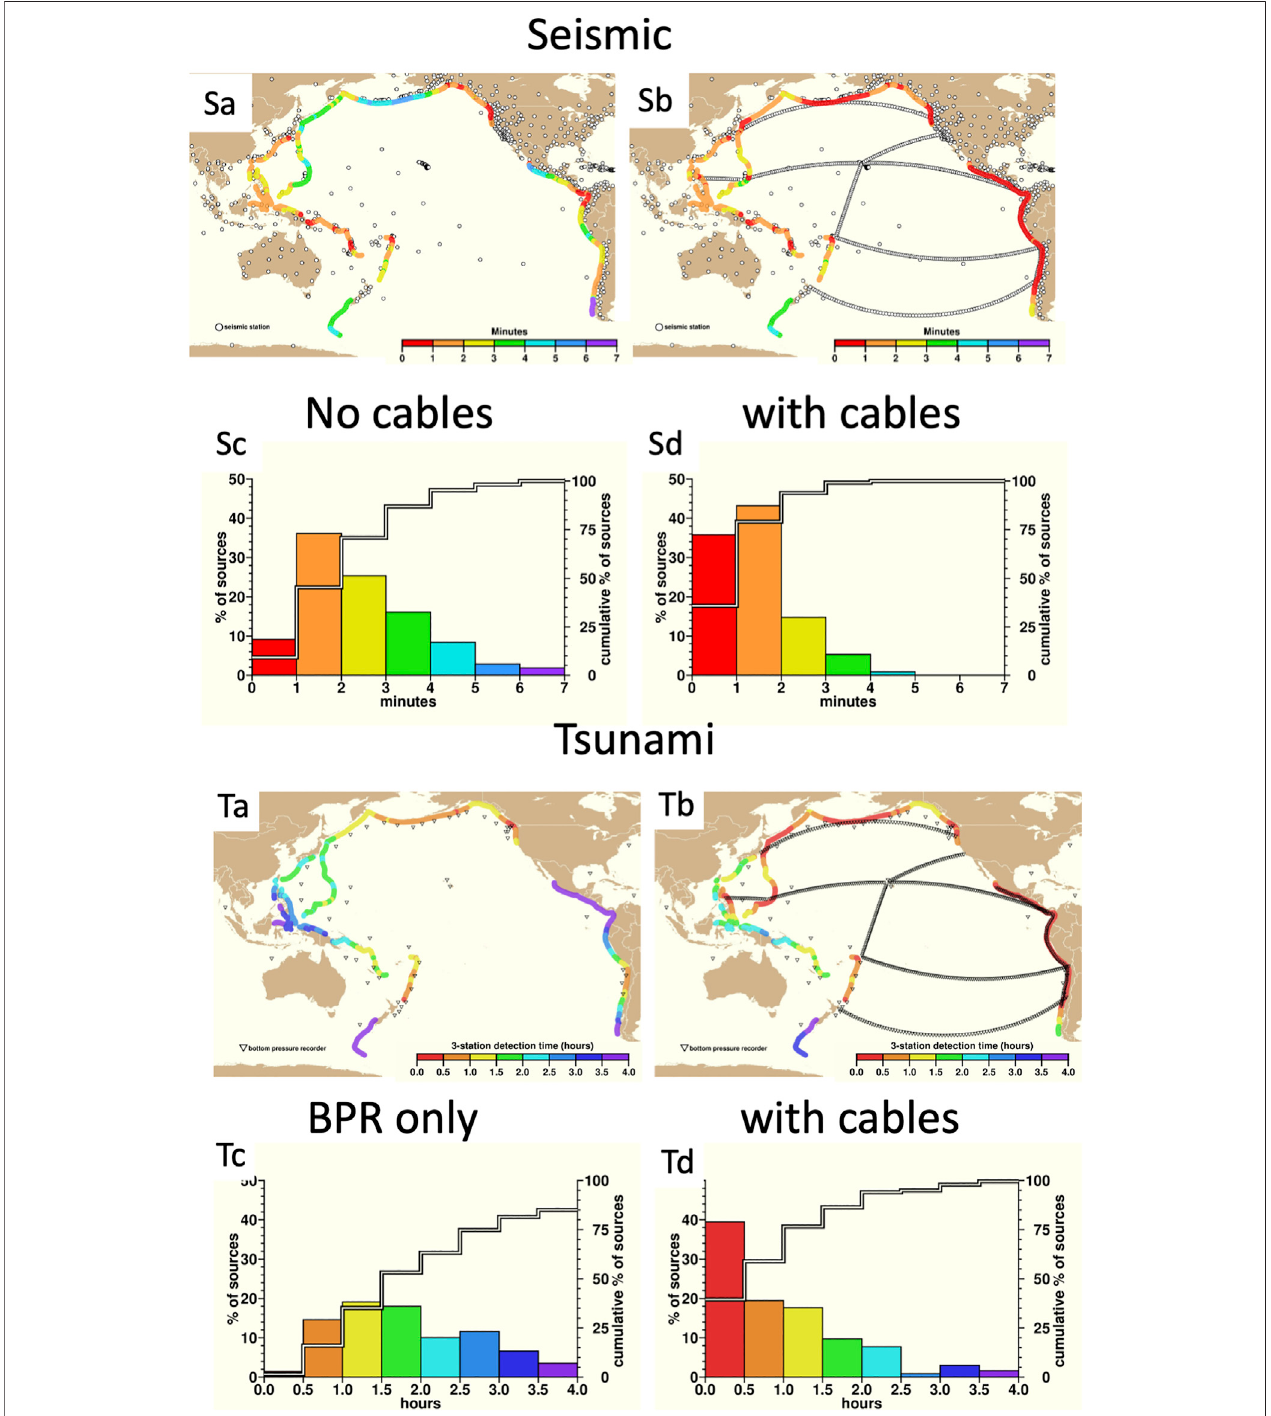
FIGURE 5 | Maps Sa and Sb (top) show existing seismic stations alone (Sa, gray circles) and then with six simulated SMART cables (Sb, repeaters gray circles), respectively.Coloreddotsrepresent simulatedmegathrust subductionearthquakeepicenters,andthecolorbarsthetimetodetection(0 – 7 min).Maps TaandTbshow existingDARTbottompressurerecorder(BPR)stations(triangles)andthenwithsixsimulatedSMARTcables(repeatersgraycircles),respectively.Thecolorbarsdenote the time to detection (0 – 4 h). Again, dots in both cases represent simulated potential megathrust subduction earthquake epicenters and the color bars the time to detection (red represents shorter time). The lower histograms are used to obtain statistics as discussed in the text.